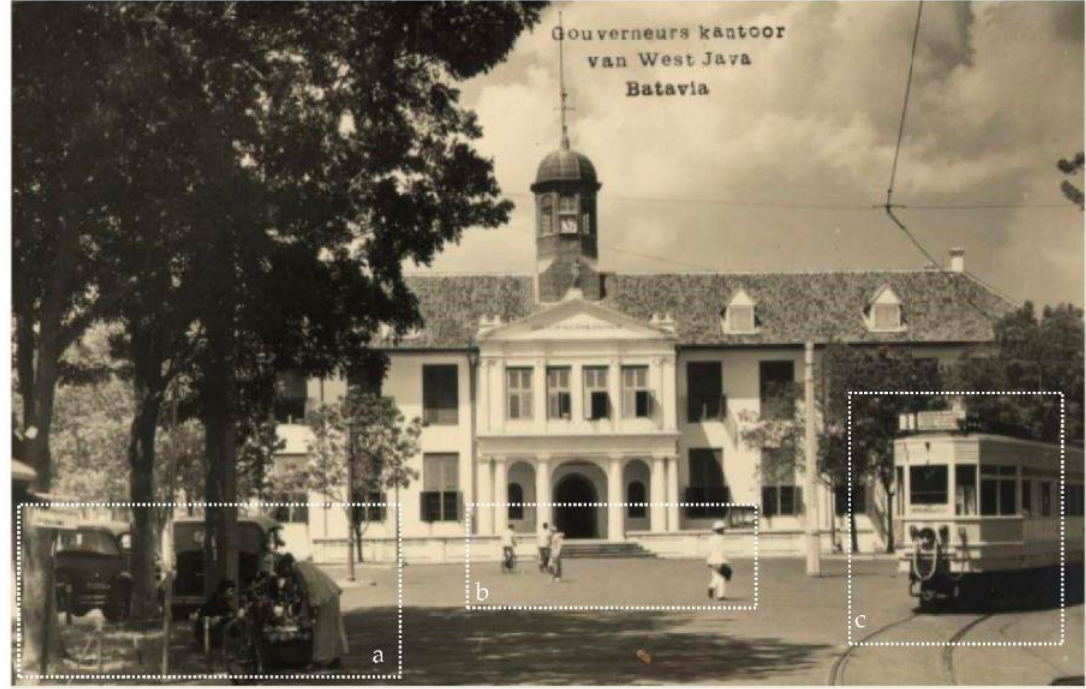
Figure 11. The situation of Stadhuis de Batavia in 1936. Identified sound sources: ( a ) vehicles ( b ) humans ( c ) tram. Source: Leiden University Digital Collections.